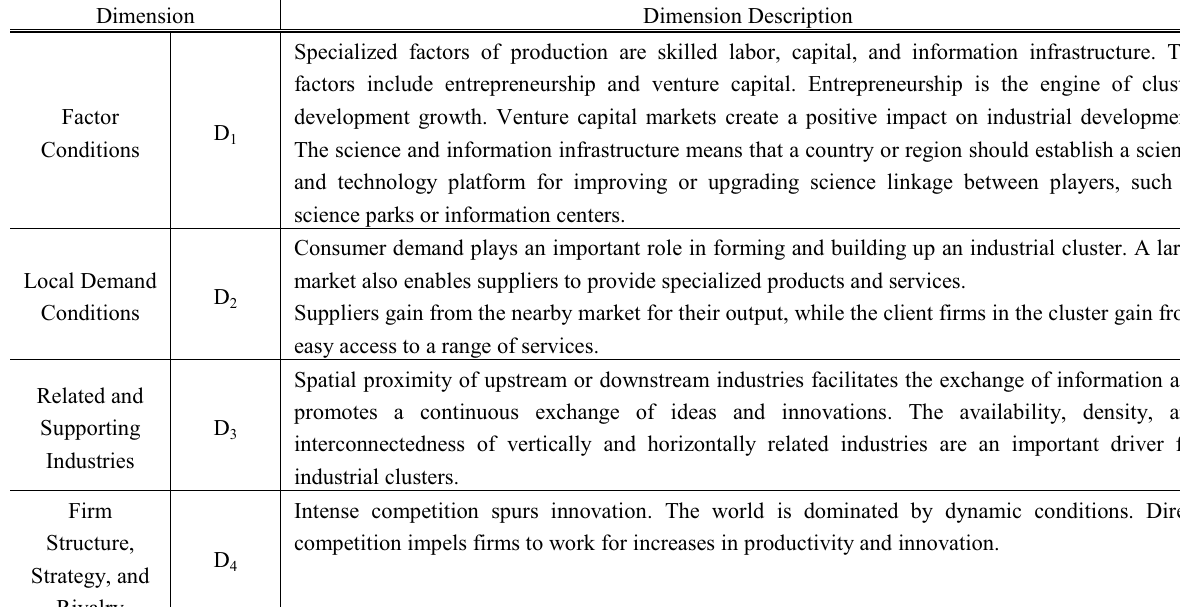
Table 1 The Critical Success Factors of EDA